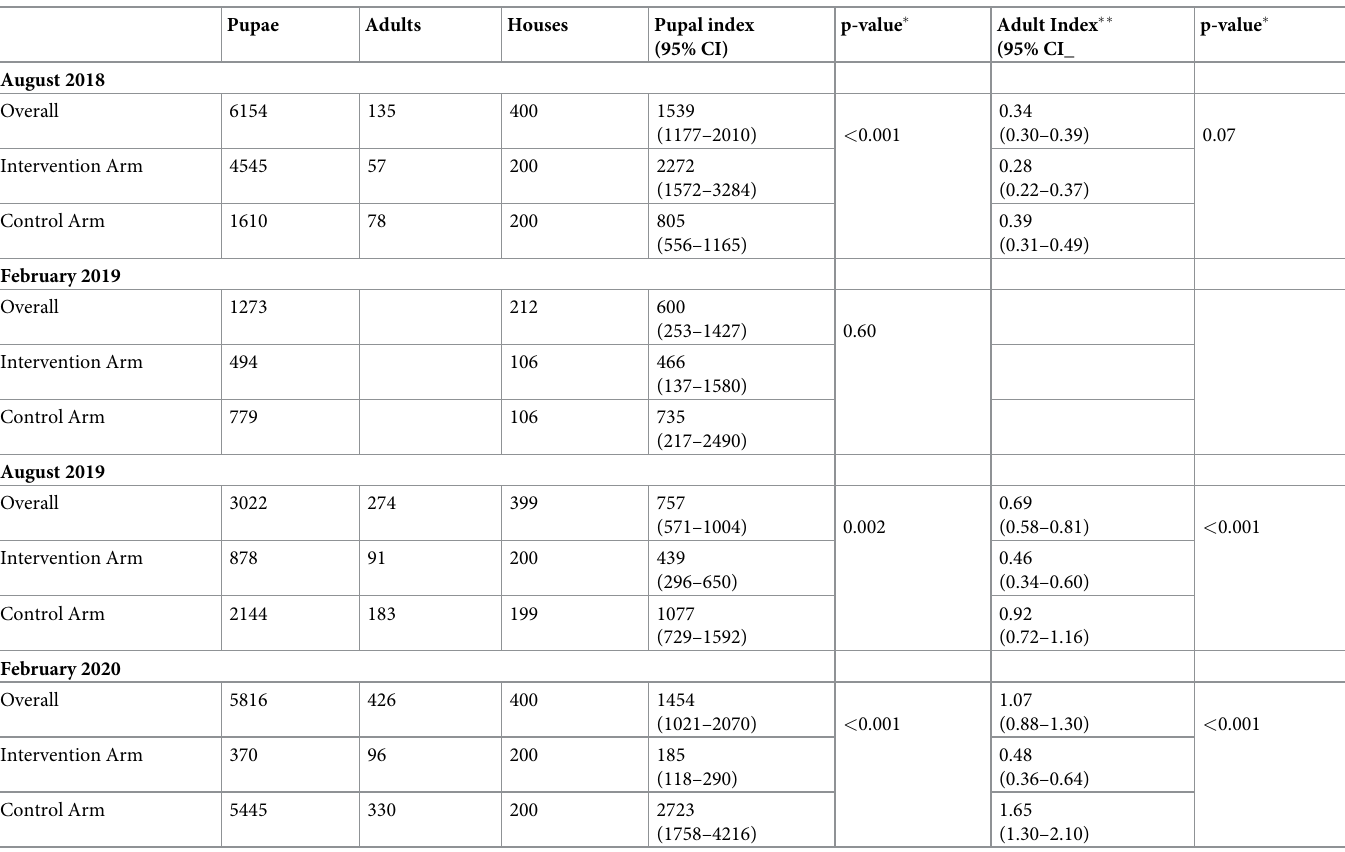
Table 3. Pupal Index and Adult Index by survey time